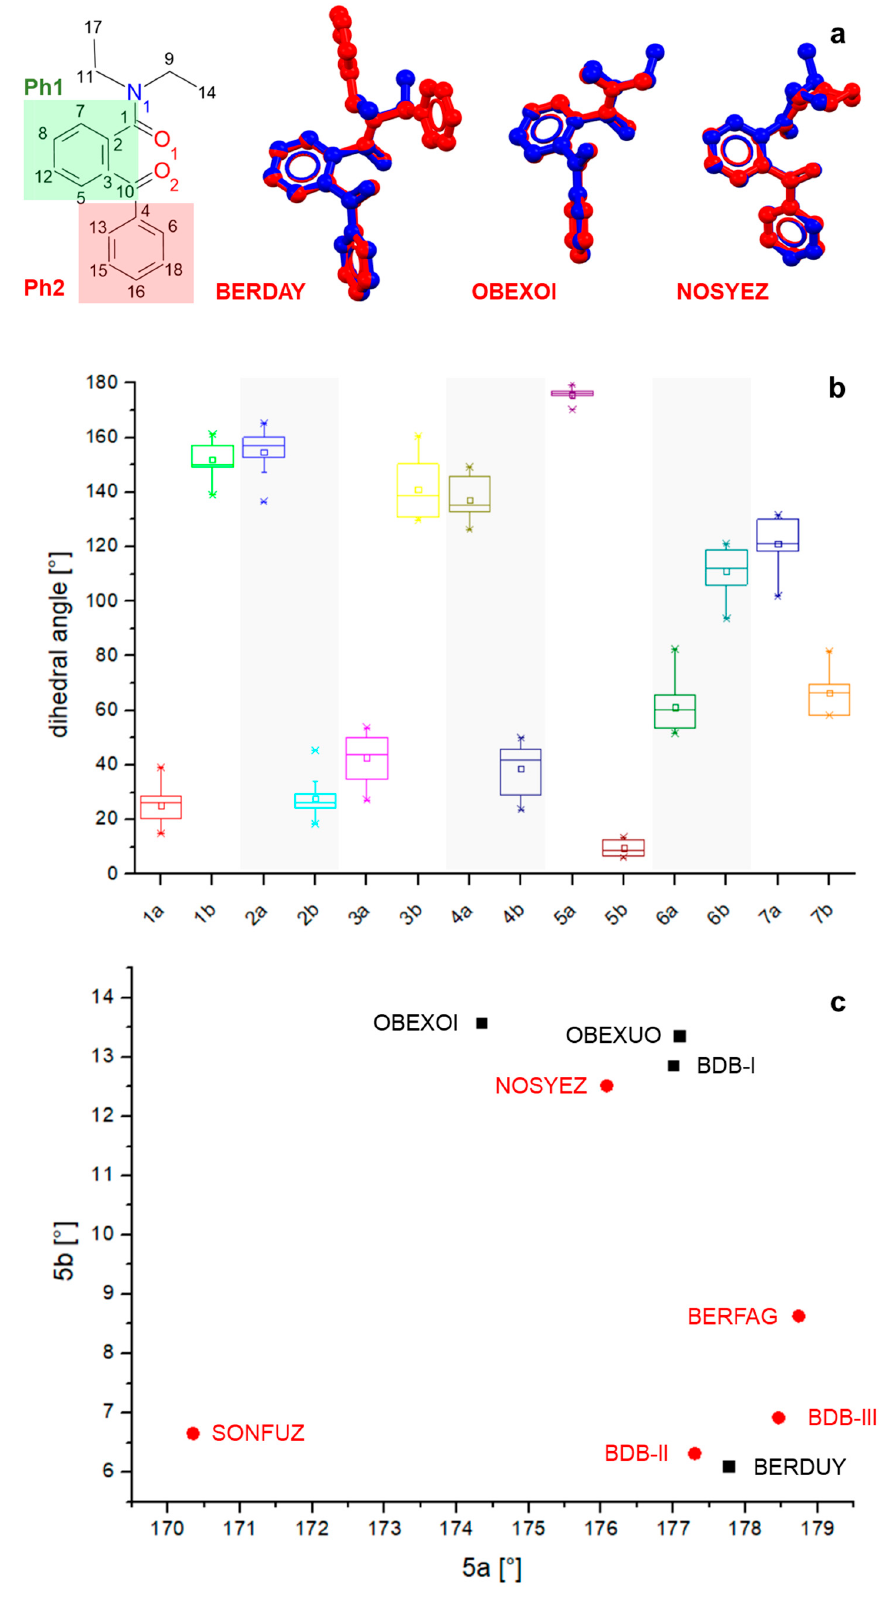
Figure 2. Structure overlay between BERDAY, OBEXOI and NOSYEZ, in red, using BDB form I as a reference in blue ( a ), boxplots for distribution of torsion angles pairs 1–7 ( b ) and scatterplot between torsion angles 5a and 5b, where compounds that crystallize as racemates are in red and compounds that crystallize as racemic conglomerates are in black ( c